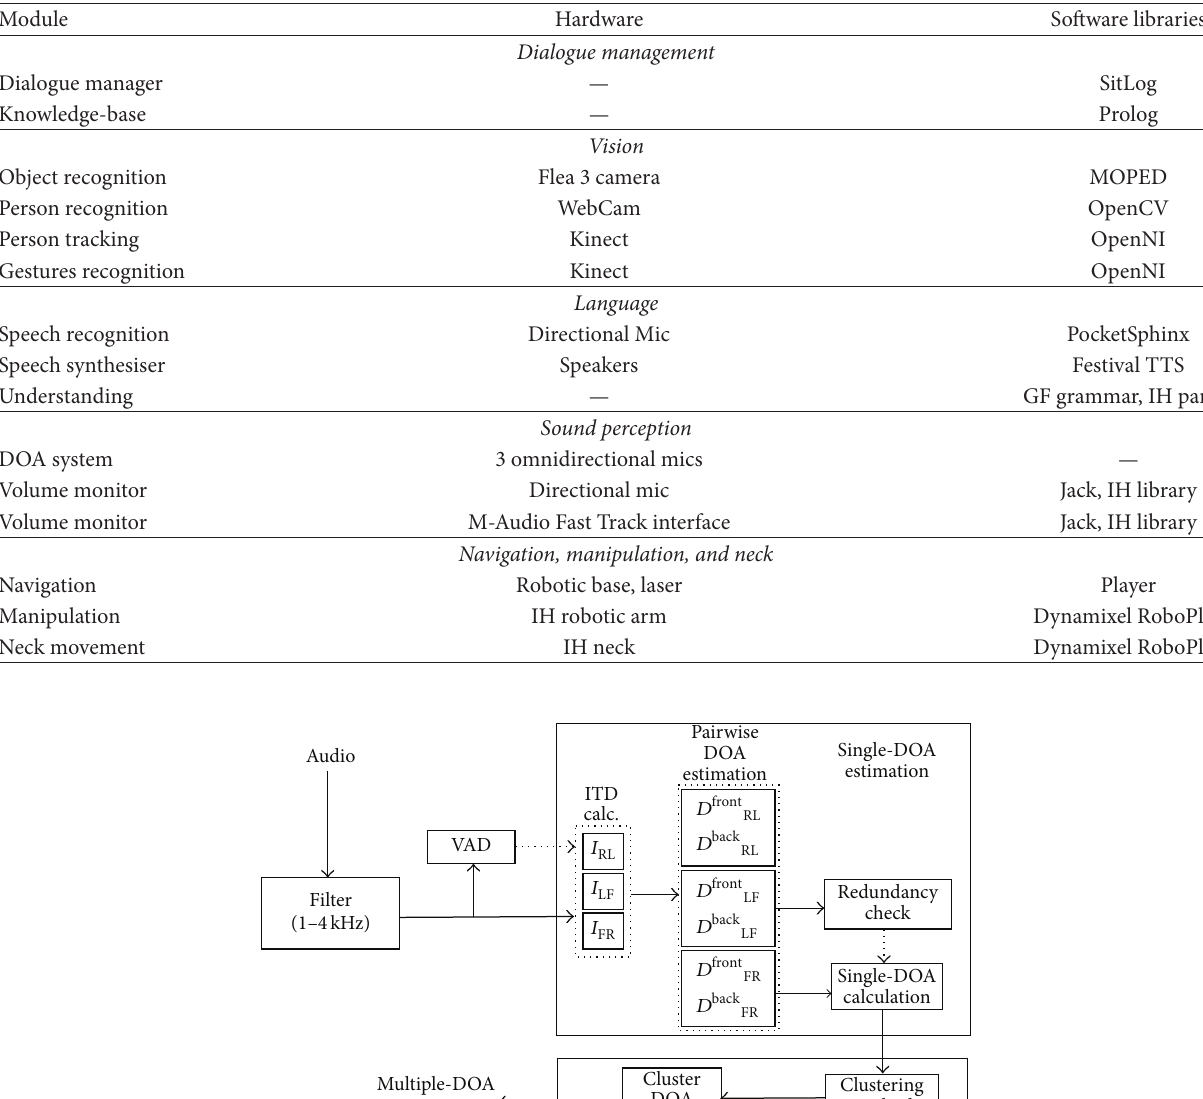
Table 2: Capabilities, modules, and hardware used on the Golem-II+ robot (IH: in-house developed).